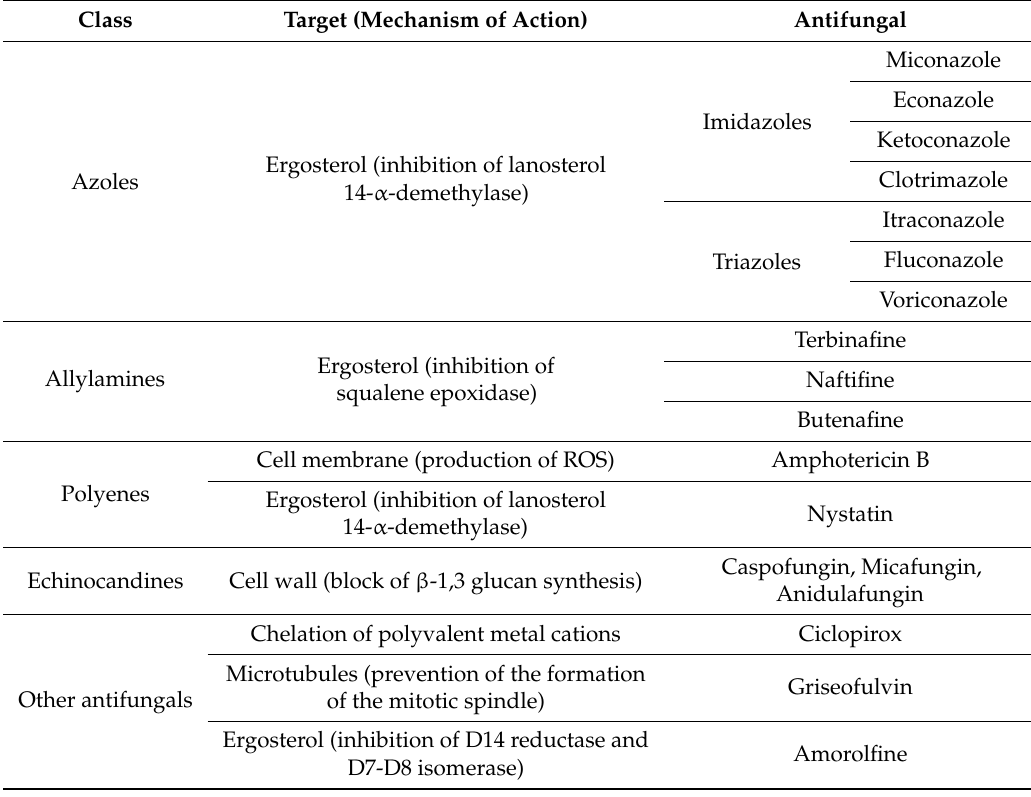
Table 1. Targets of each group of antifungals